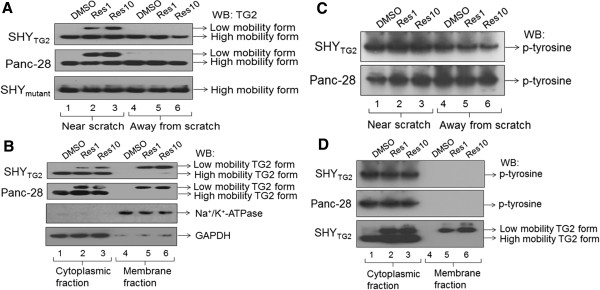
Detection of TG2 protein under non-denaturing conditions. (A) Representative Western blots for TG2 in total cellular proteins isolated from resveratrol-treated SHYTG2, SHYmutant and Panc-28 cells present near and away from the scratch. Equal amount of proteins were separated on non-denaturing conditions and Western blots were done with anti-TG2 antibody. In addition to the major TG2 band, another TG2 protein band with lower migration was detected in resveratrol-treated SHYTG2, and Panc-28 cells present near the scratch. (B) Representative Western blots for TG2 with cytoplasmic and membrane protein fractions prepared from DMSO- or resveratrol-treated SHYTG2, and Panc-28 cells present near the scratch. Under non-denaturing conditions, TG2 protein band with slower migration was present in both cytoplasmic and membrane protein fractions prepared from resveratrol-treated (1 and 10 μM) cells. (C and D) Western blots using anti-tyrosine antibody to detect phosphorylation state of TG2 in total cell extract (C) and cytoplasmic and membrane protein fractions (D). Native proteins (100 μg) isolated from resveratrol or DMSO treated SHYTG2 and Panc-28 cells present near the scratch, separated on non-denaturing gels followed by Western blot with anti-phosphotyrosine (p-tyrosine). The bottom panel (D) represents the Western blot for TG2 in SHYTG2 cells.